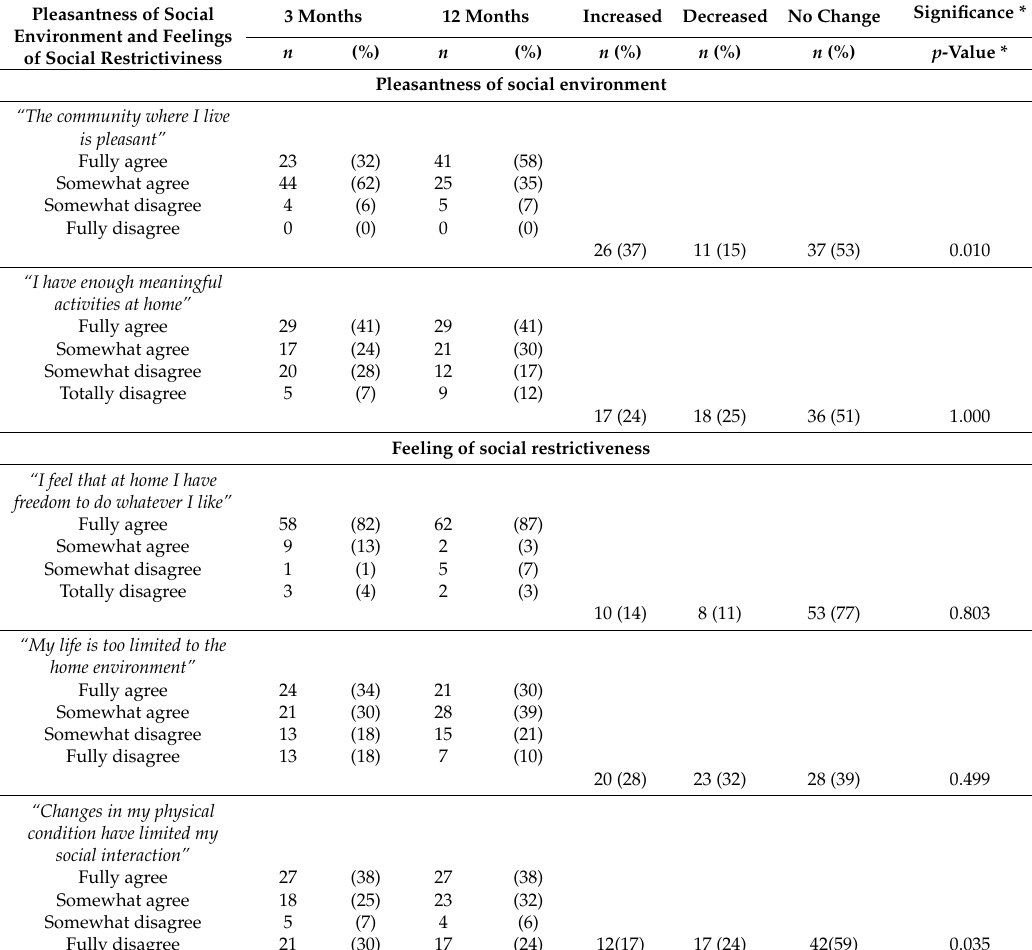
Table 2. Self-reported pleasantness of social environment and feelings of social restrictiveness and changes in these variables 3 and 12 months after relocation to senior